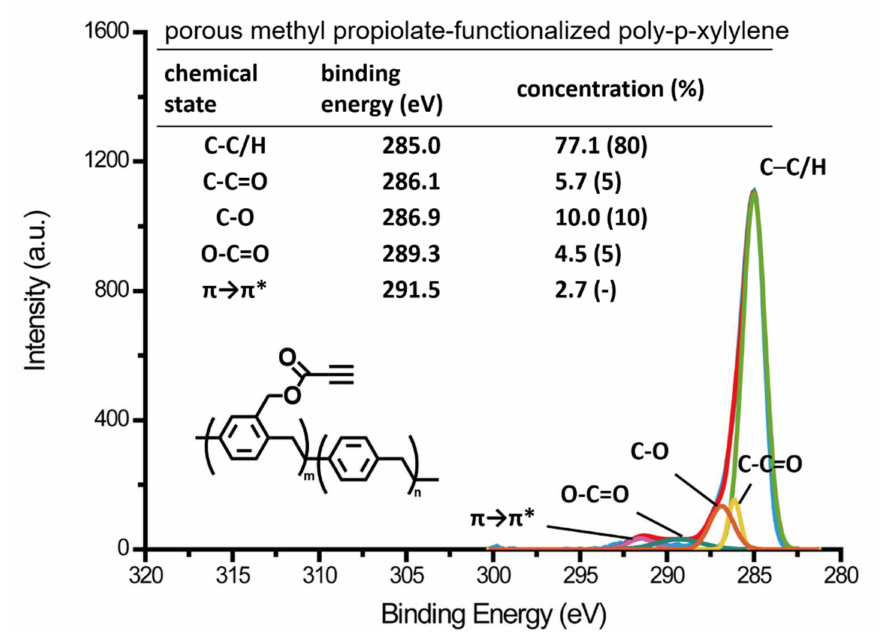
Figure 5. The XPS high-resolution C 1s spectra confirmed the details of the chemical structure of the fabricated porous methyl propiolate-functionalized poly- p -xylylene. The experimental values of the binding energies and the component concentrations were found to be consistent with the calculated theoretical